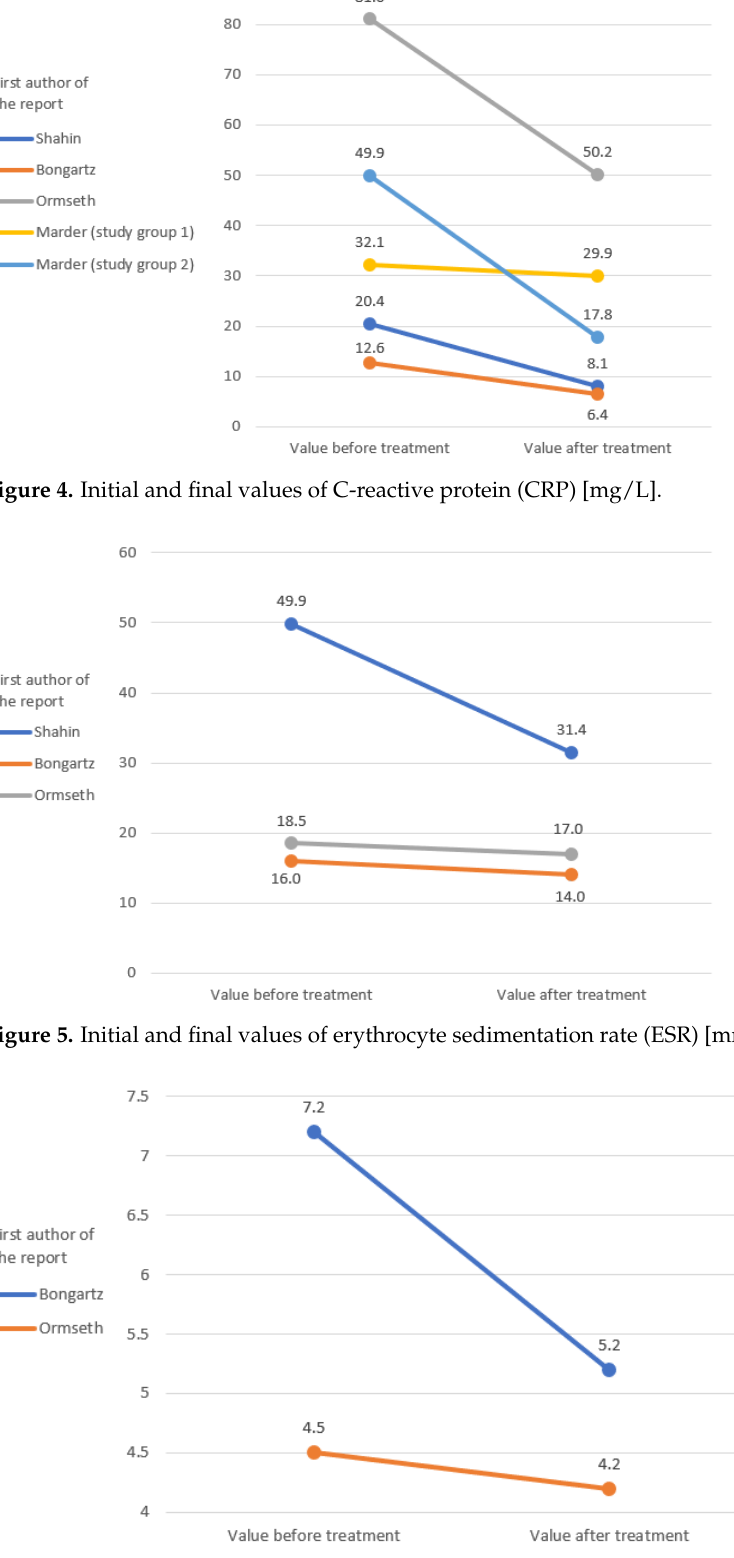
Figure 6. The initial and final value of the visual analog scale (VAS) pain.